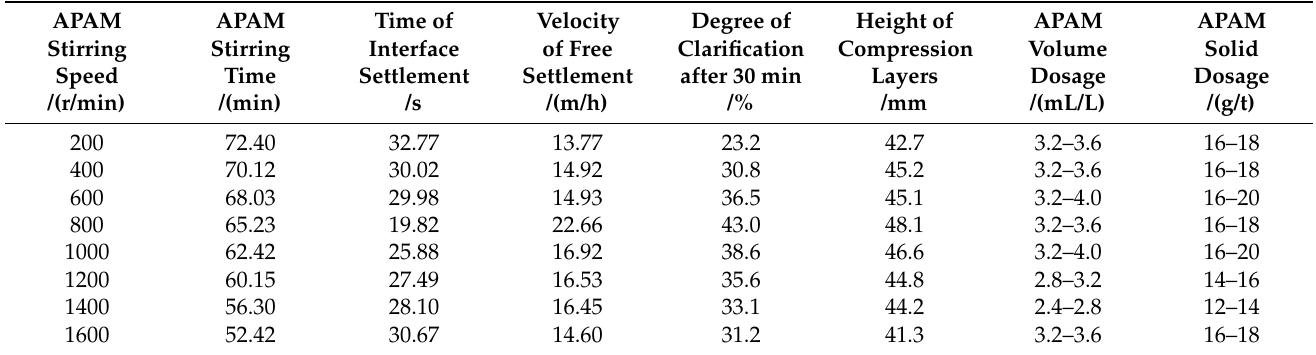
Table 4. Analysis of the percentage of each particle size and ash content of coal samples Slime Size/mm − 0.5